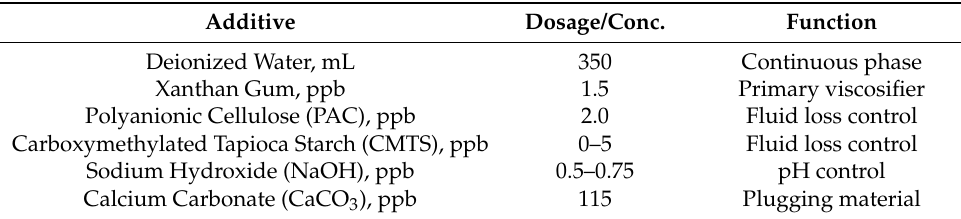
Table 2. Mud Composition. Additive